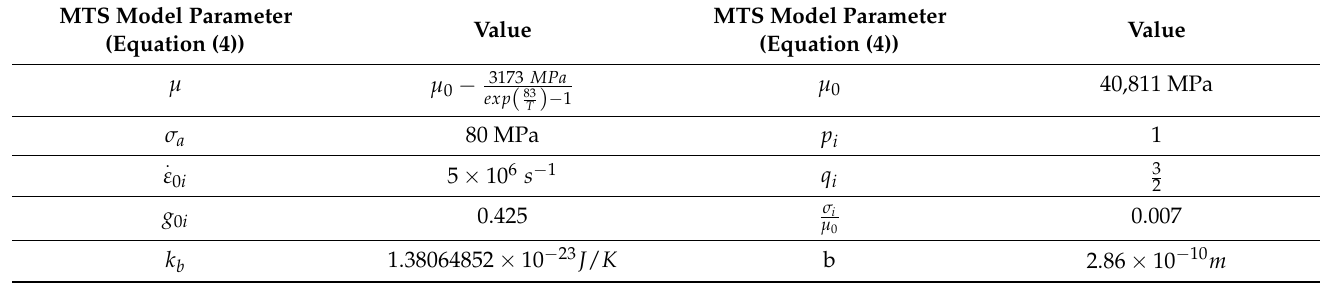
Table 2. MTS model parameters.